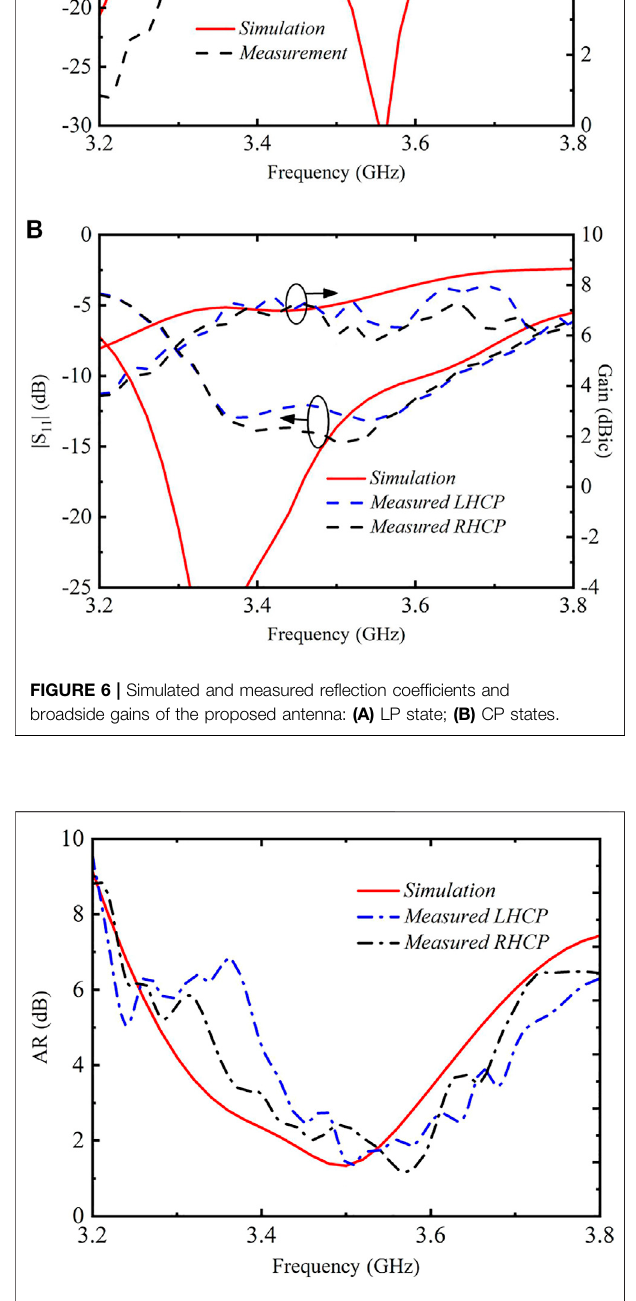
FIGURE 7 | Simulated and measured ARs of the proposed antenna for two CP